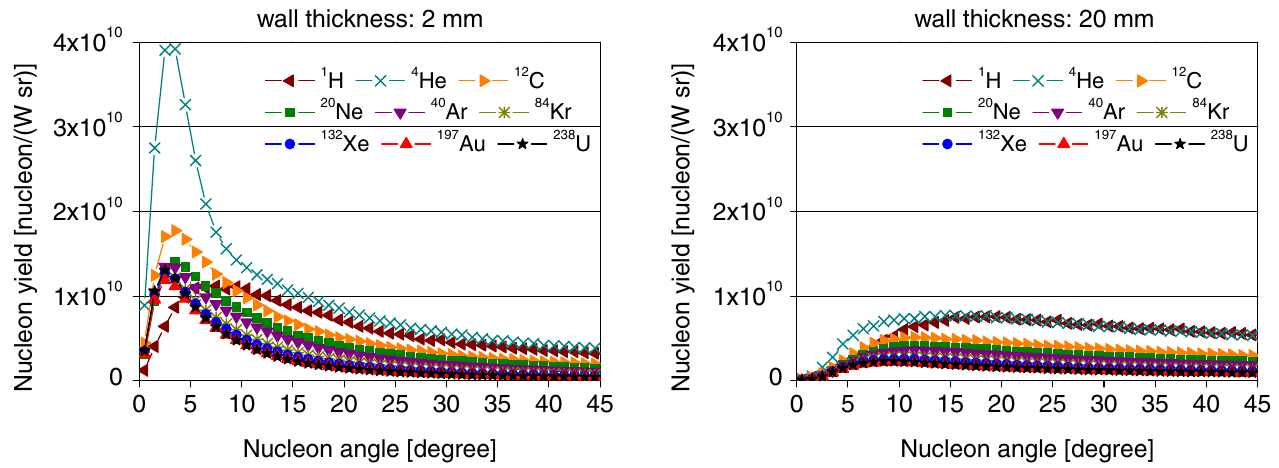
FIG. 12. (Color) Angular distribution of nucleons escaping from the beam pipe for wall thickness of 2 and 20 mm. The angles are given with respect to the beam-pipe longitudinal central axis. The relative standard uncertainty of the presented data is less than 1%.